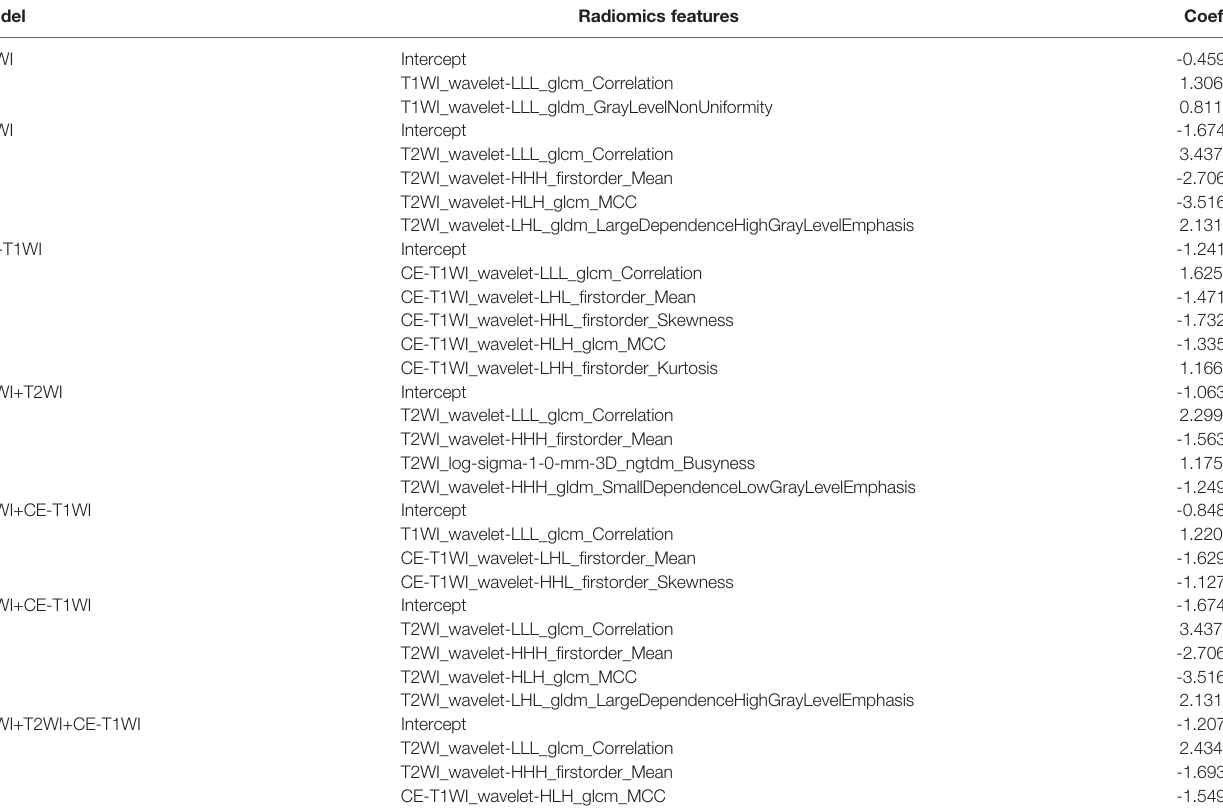
TABLE 5 | The most signi fi cant radiomics features of different models. Model